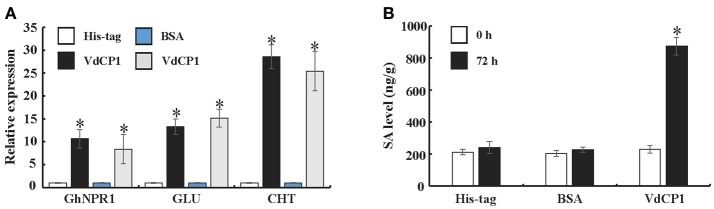
Systemic induction of defense genes and SA by infiltration with VdCP1. (A) Relative expression levels of GhNPR1, GLU, and CHT in untreated cotton roots at 72 h post inoculating cotyledons with 100 μM VdCP1, His-tag or BSA. (B) Systemic induction of SA levels in cotton roots by treating the cotyledons with 100 μM VdCP1, His-tag or BSA. Asterisks indicate a statistically significant difference (p < 0.05 by Student's t-test).